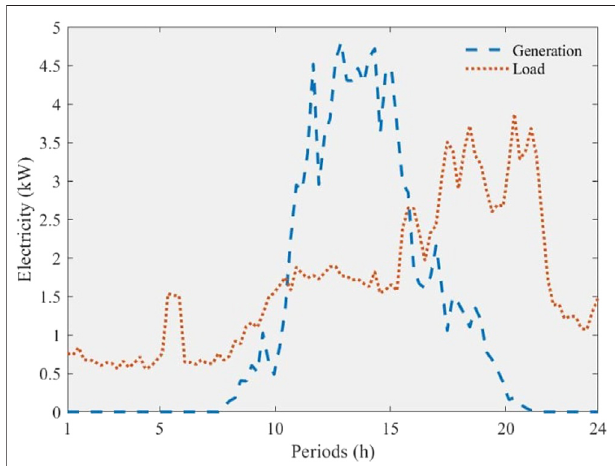
FIGURE 3 | Mean pro fi les of prosumers.